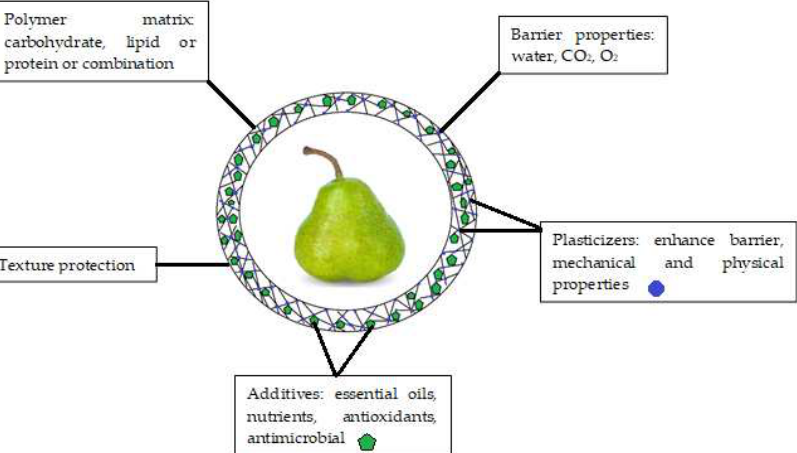
Figure 2. Main components and functions of edible coatings.